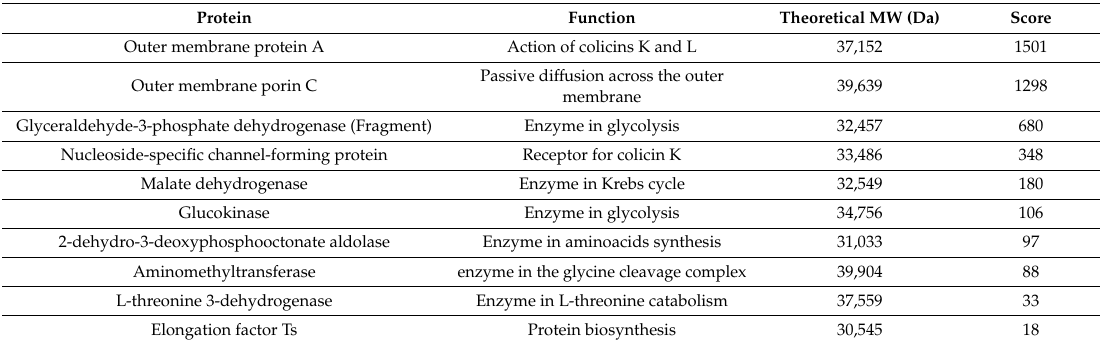
Figure 1. Coomassie-stained SDS-PAGE (10%) protein profiles of K. pneumoniae ATCC 10031, MS K. pneumoniae and KPC-producing K. pneumoniae and relative OMVs. Molecular mass marker (MW) is expressed in kilodaltons (kDa). The rectangles indicate the bands subjected to trypsin digestion and MS and MS/MS analysis. Table 4. Protein profile commonly present in OMVs purified from di ff erent K. pneumoniae strains. Table 4. Protein concentration of OMVs purified from different strains of K. pneumoniae.